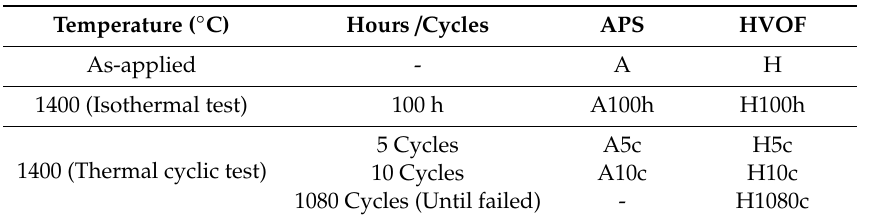
Table 2. TBC sample abbreviations.